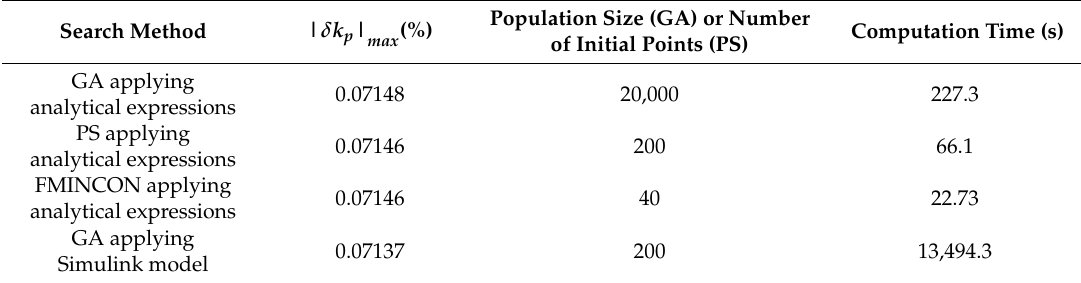
Table 3. Comparative analysis of the applied search